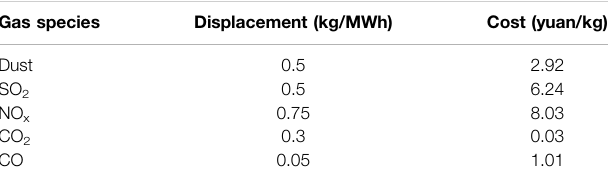
TABLE 3 | Type and cost of emissions.